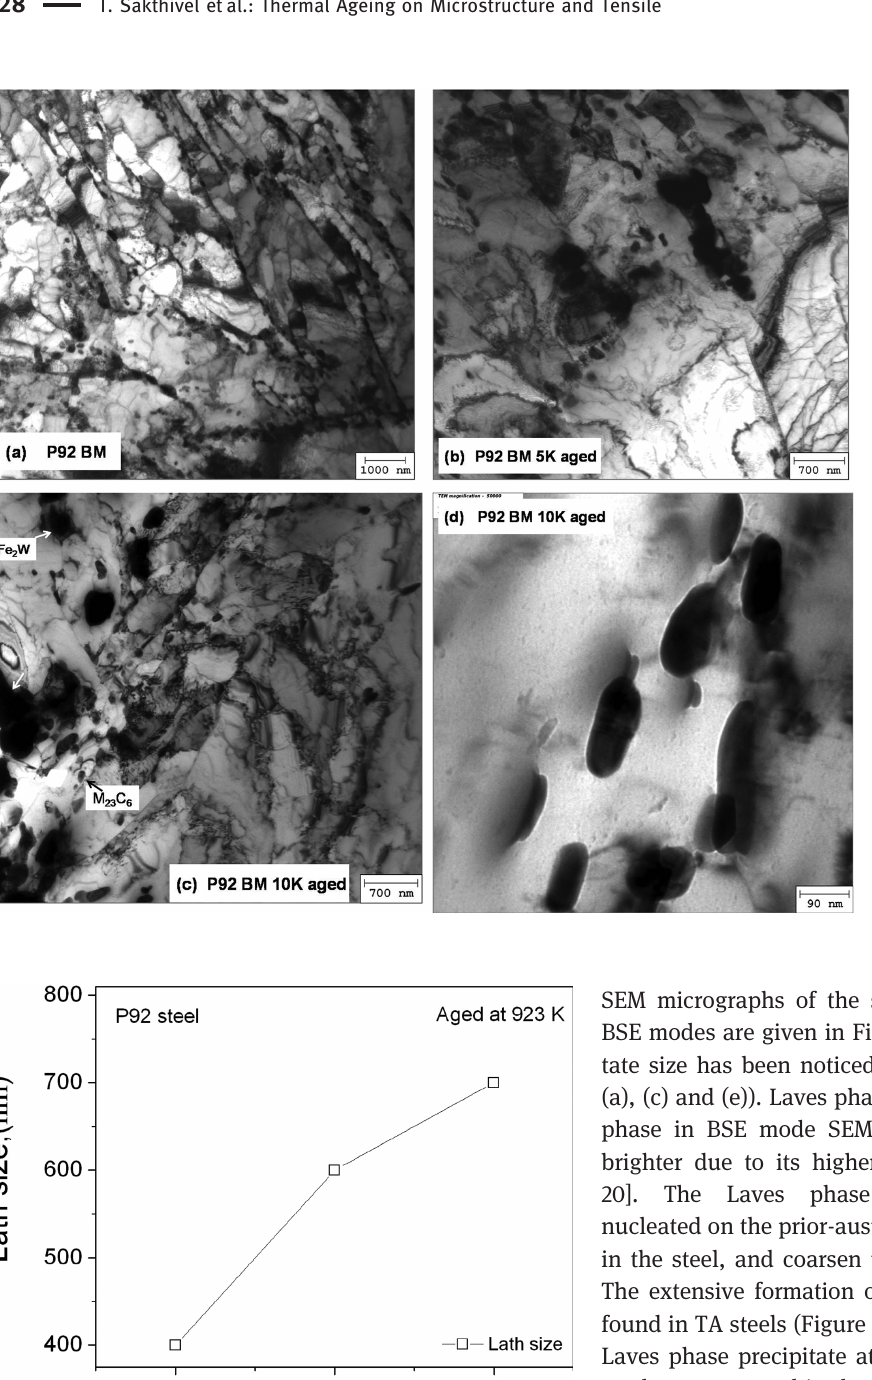
Figure 3: Variations of lath width of P92 steel in the normalized and tempered, and thermal-aged conditions at 923 K for 5000 h and 10,000